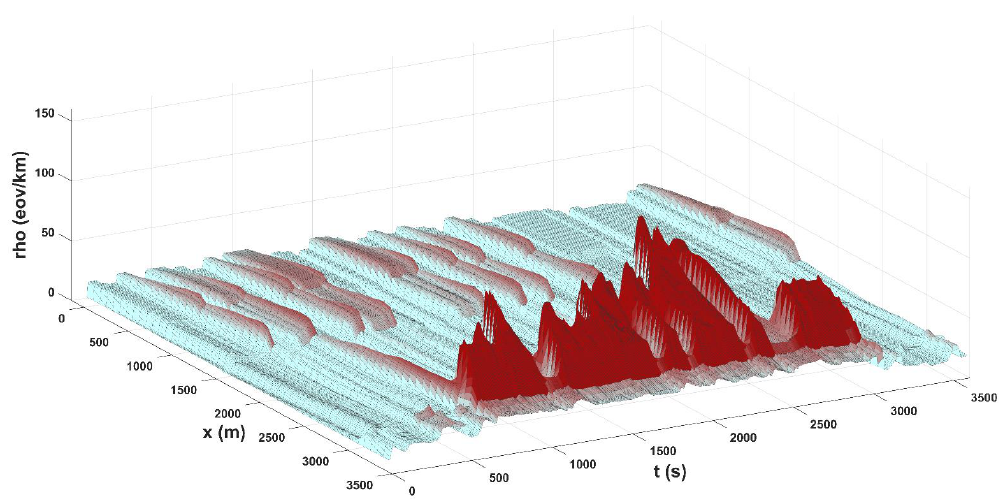
Figure 4. Density in time and space in scenario 2.